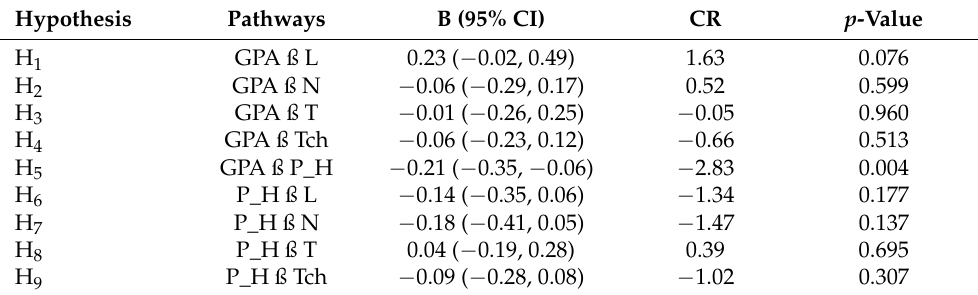
Table 7. Hypothesized path relationships in the final model